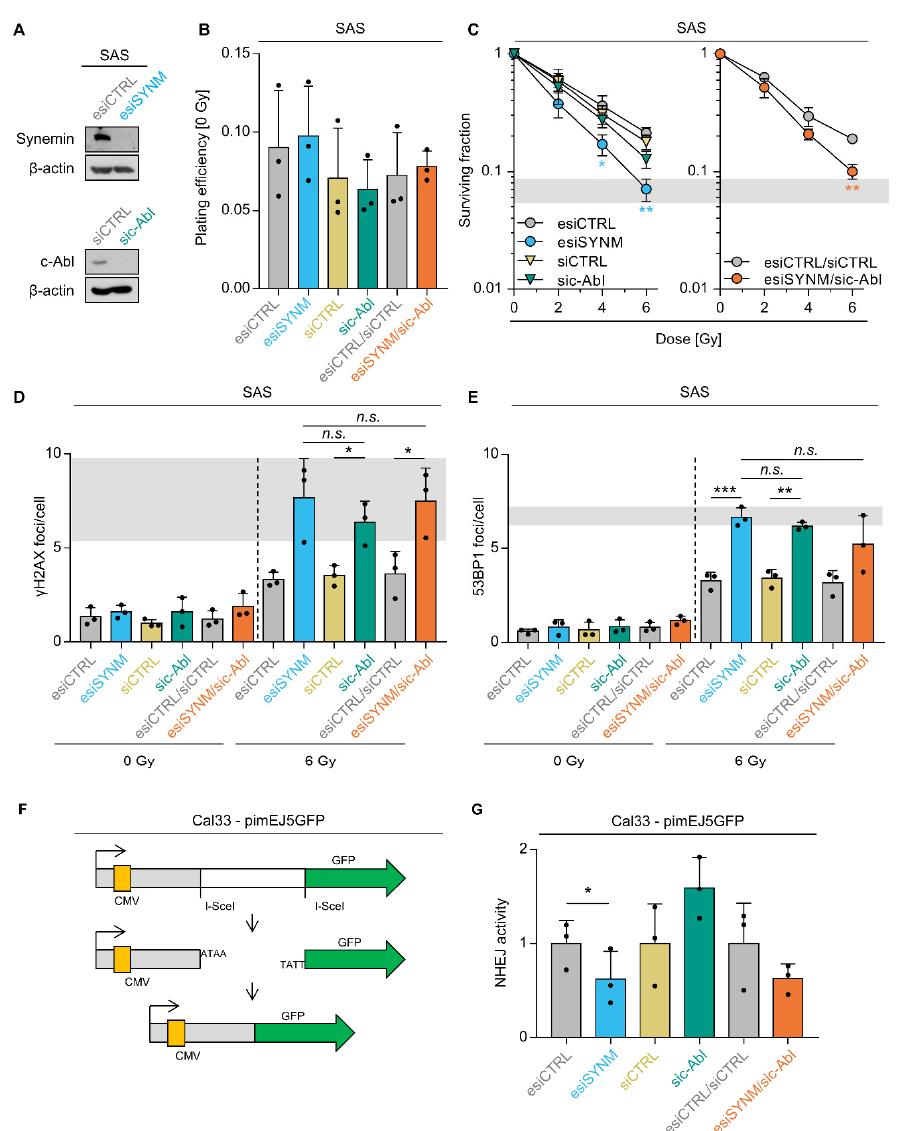
Figure 5. Reduced activity of DNA repair and radiosensitization after Synemin/c-Abl knockdown. ( A ) Knockdown efficiencies of indicated control and specific esi/siRNA in whole cell lysates from SAS cells. β -actin served as loading control. ( B ) Plating efficiency of SAS cells upon single or double knockdown of synemin and c-Abl. Dots represent the mean of each independent experiment. ( C ) 3D clonogenic radiation survival upon single or double silencing of synemin and c-Abl. ( D ) Residual γ H2AX and ( E ) residual 53BP1 foci per cell upon single or double knockdown of synemin and c-Abl in 6 Gy X-ray irradiated SAS cells. Transfection with single or double non-specific siRNA was used as controls. Dots represent the mean of each independent experiment. ( F ) Schematic structure of the NHEJ substrate pimEJ5GFP. The pimEJ5GFP has an insertion between the CMV promoter and GFP preventing its translation. Once the endonuclease I-SceI cuts in the proper sites it generates a DSB that can be repair by NHEJ. ( G ) NHEJ activity in Cal33 cells upon single or double knockdown of synemin and c-Abl. Dots represent each independent experiment. Data are represented as mean ± SD ( n = 3; two-sided t -test; * p < 0.05, ** p < 0.01, *** p < 0.001; n.s., not significant ( p ≥